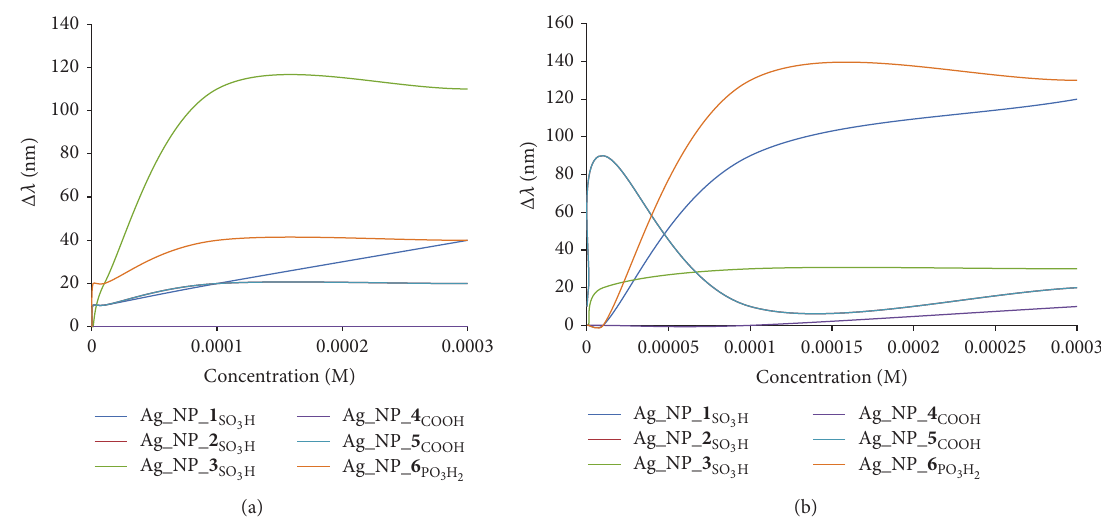
F 4: e delta values of the maximum wavelength of Ag_NP_Calix[n]arene as a matter of concentration of API mixed during 1 hour with (a) chlorhexidine and (b) gentamycine sulfate.